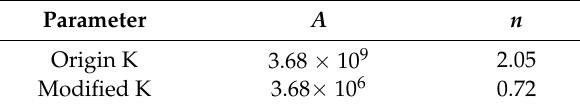
Table 2. Original K and modified K.